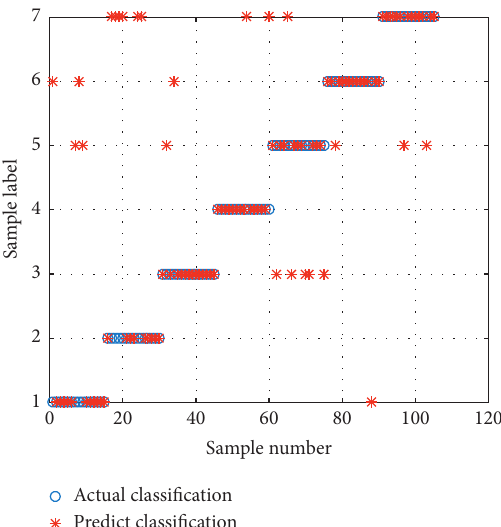
Figure 14: Classification results of IEWT-KNN when K �